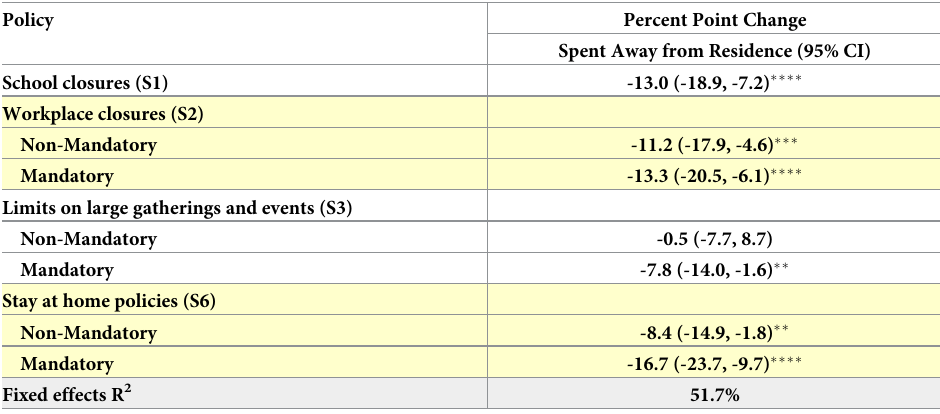
Table 1. Relationship between social distancing policies and changes in